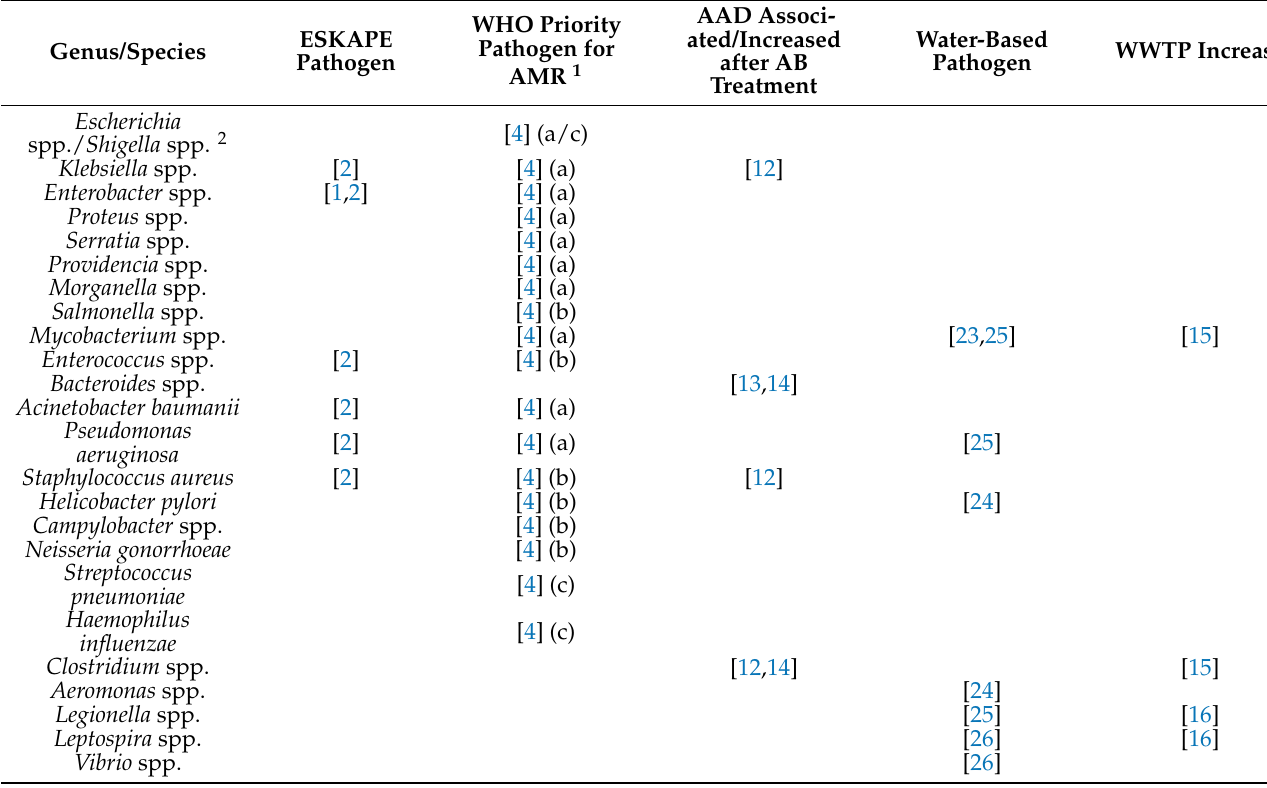
Table 2. Target taxa. Taxa that include pathogenic bacteria of clinical interest monitored from wastewater to environment. If no reference is given in the cell, the bacteria does not fall under this category.